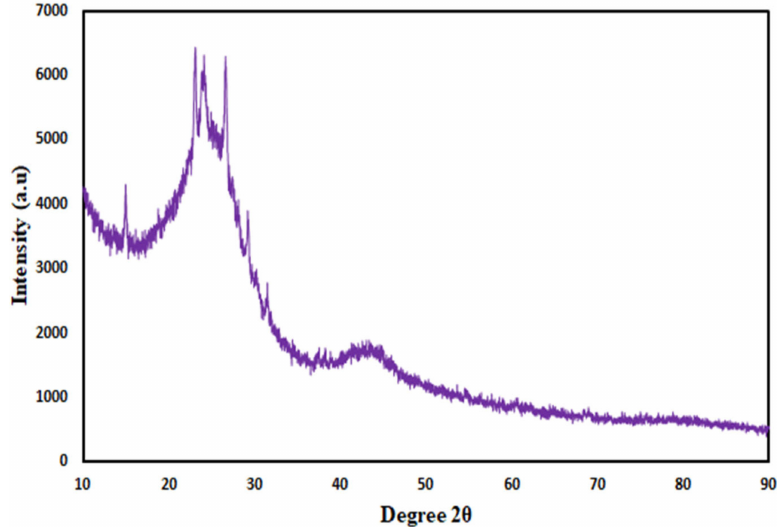
Figure 4. XRD analysis of activated